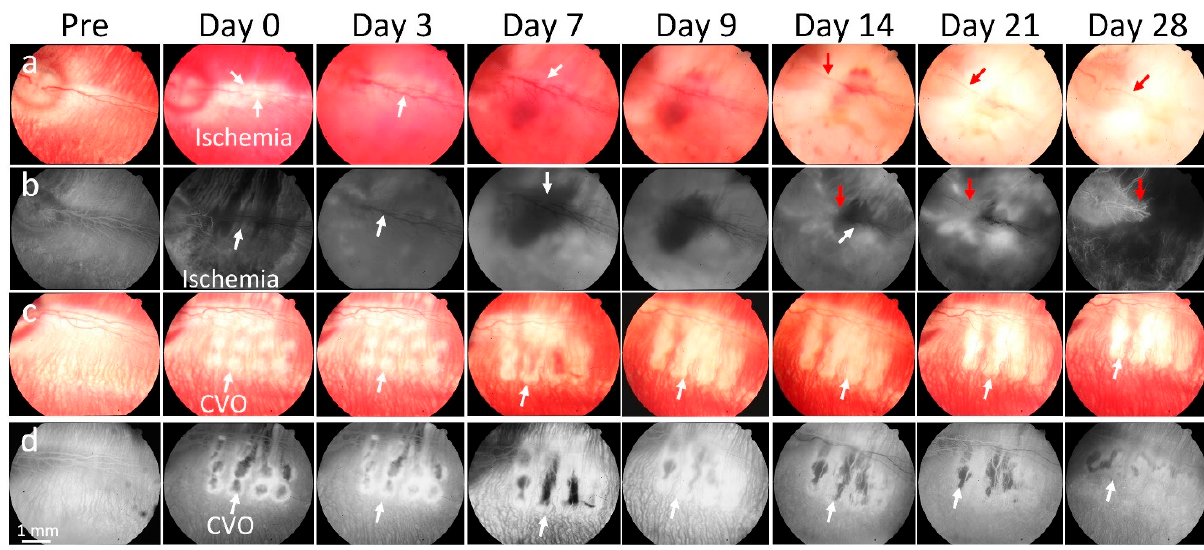
Figure 2. In vivo imaging of retinal and choroidal vascular occlusion: ( a ) color fundus photography, ( b ) fluorescein angiography (FA) imaging of retinal vein occlusion (RVO). ( c , d ) Color and FA images of choroidal vascular occlusion (CVO). Images of RVO and CVO acquired pre- and post-laser treatment at different time points: Day 0, 1, 3, 7, 14, 21, and 28. White arrows indicate the targeted treatment areas. Color intensity (color fundus) or fluorescent intensities (FA) reduced post-treatment, confirming the location of RVO and CVO. Hemorrhage appeared at day 7 and 9 post-laser treatment. Red arrows show the new retinal vessels created from day 14.